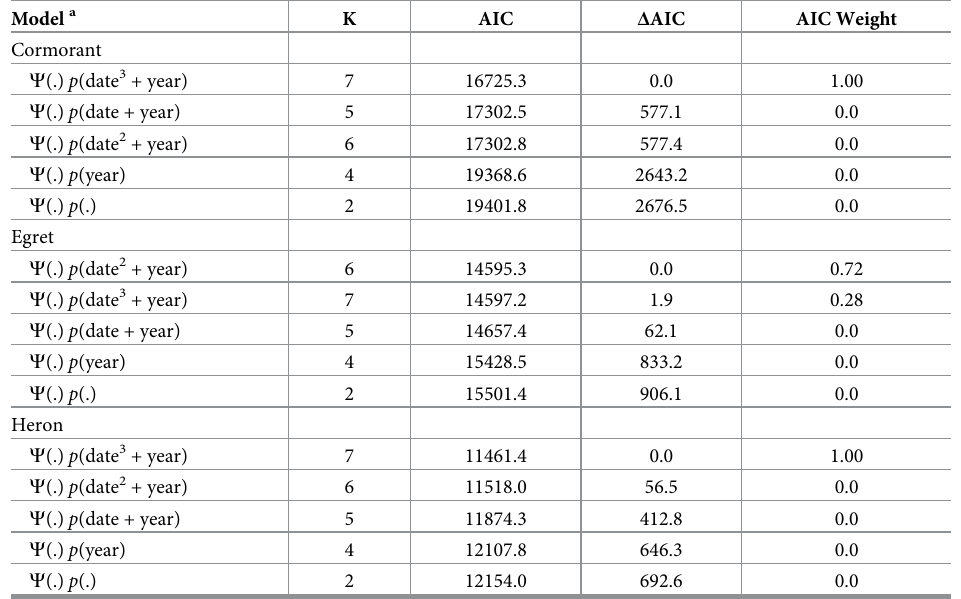
Table 2. Detection models ( p ) constructed for cormorants, egrets, and herons with constant occupancy ( C ) prob- ability. Parameters included in top ranked detection models were included in occupancy model construction. Number of parameters (K), AIC, Δ AIC, and model AIC weight are included. Models were constructed using aerial survey data collected during winters (Oct—Apr) of 2015–2016, 2016–2017 and 2017–2018, of species presence and absence on cat- fish ponds in the Mississippi Delta. N = 2,883 ponds for each